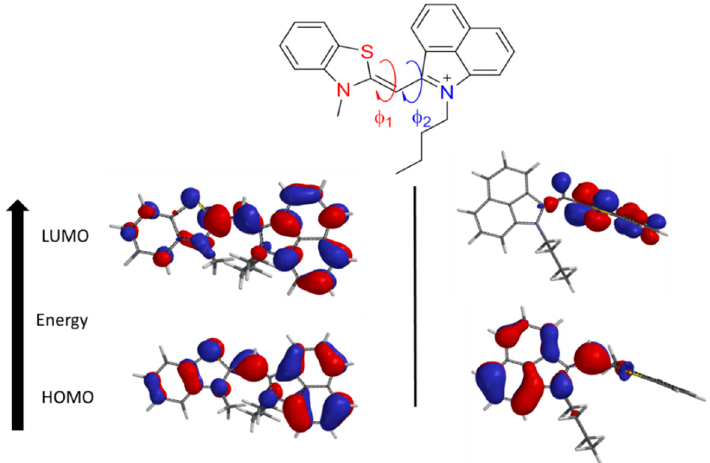
Figure 3. Frontier molecular orbitals of 6a constrained in planar ( left ) and twisted ( right ) configurations.